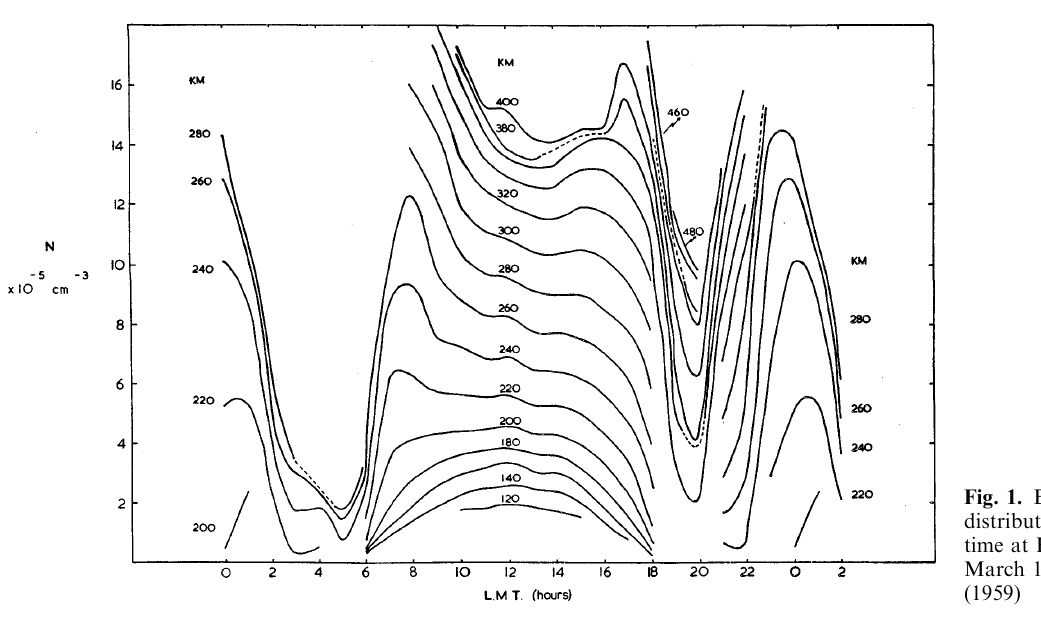
Fig. 1. Electron density N ( h, t ) distributions in height and local time at Huancayo, quiet days in March 1939, from Croom et al. (1959)